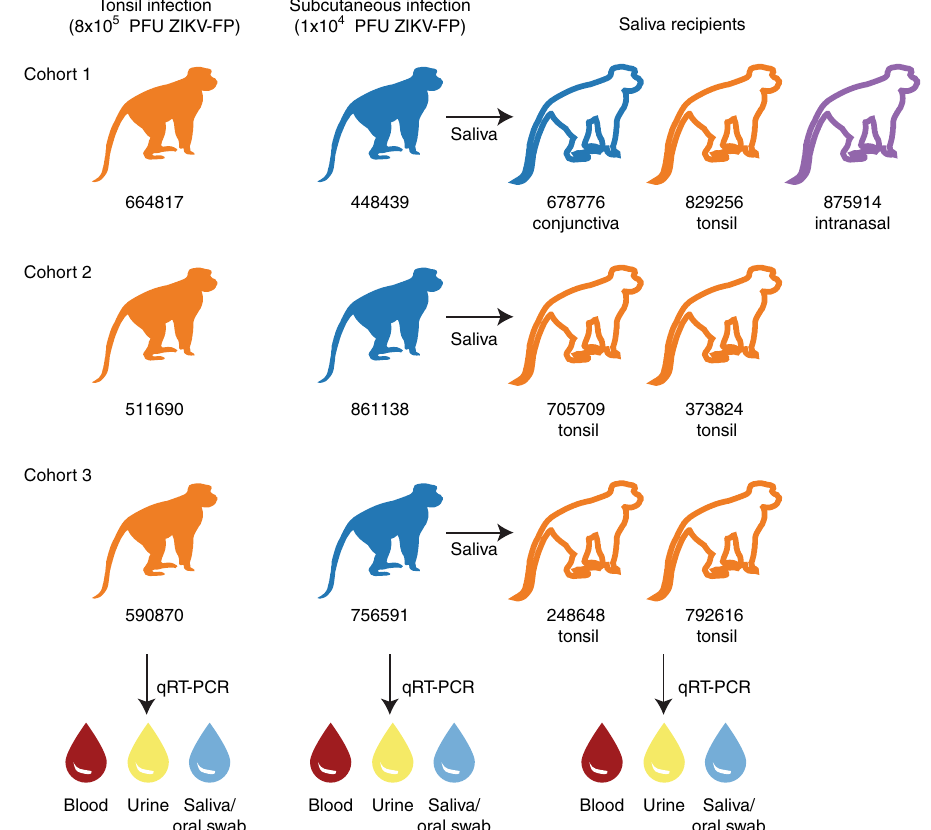
Fig. 1 Study design. Two cohorts of animals were inoculated with Zika virus either by application of stock virus to the tonsils (orange fi lled symbols) or subcutaneously ( blue- fi lled symbols ). Saliva from animals infected subcutaneously was used to challenge naive recipient animals ( open symbols ) either to the palatine tonsils, conjunctivae or nasal passages. Blood plasma, urine and oral swabs (and/or saliva) were tested for Zika virus RNA by qRT-PCR in all